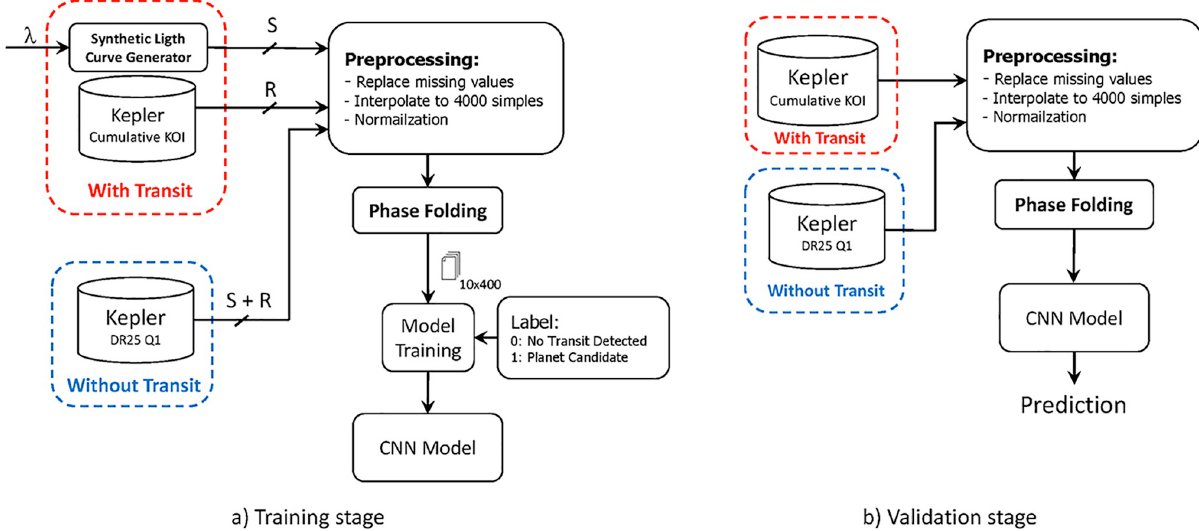
Fig 2. Training and validation stages of the proposed